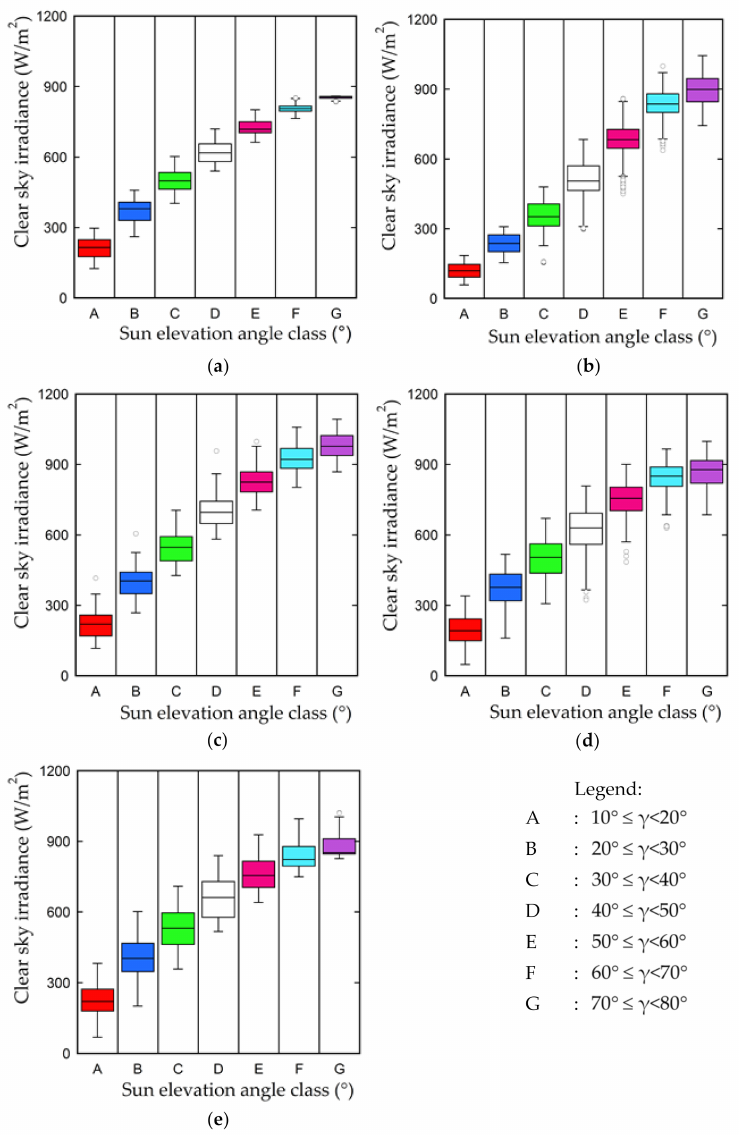
Figure 5. Clear-sky irradiance against the sun elevation angle; ( a ) Beyer, ( b ) Rigollier, ( c ) Hammer, ( d ) Perez, and ( e ) hybrid models. The sun elevation angle, γ , was divided into eight classes with the interval of 10 ◦